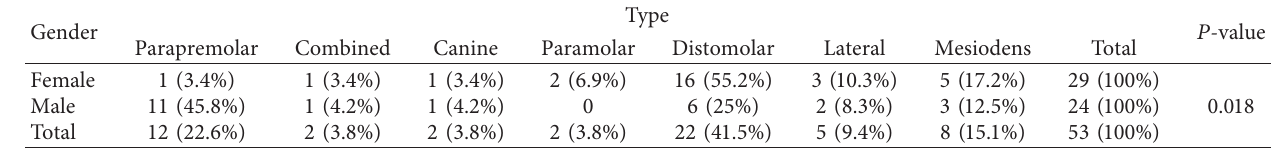
Table 4: Comparison of type of supernumerary teeth by gender.